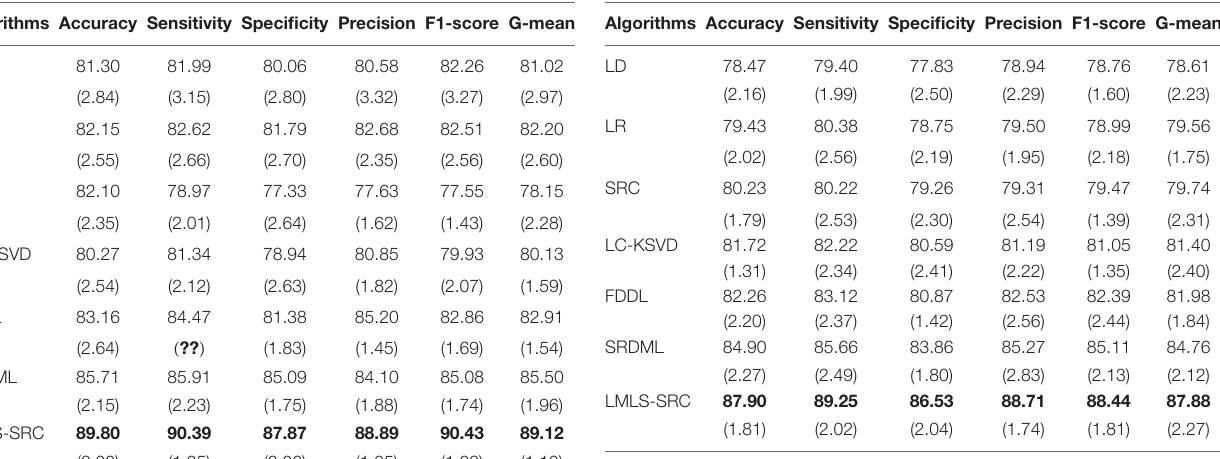
TABLE 1 | The comparative training results (with standard deviation) in binary classification task.